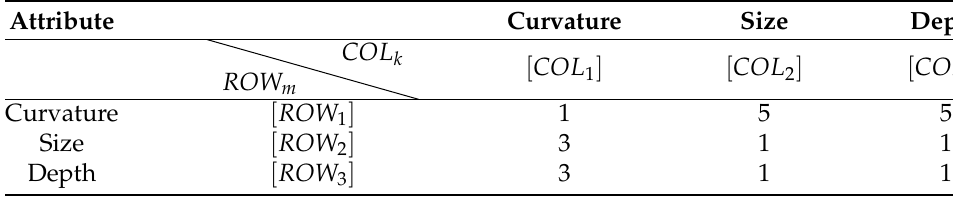
Table 3. Matrix of comparisons between the analyzed attributes.